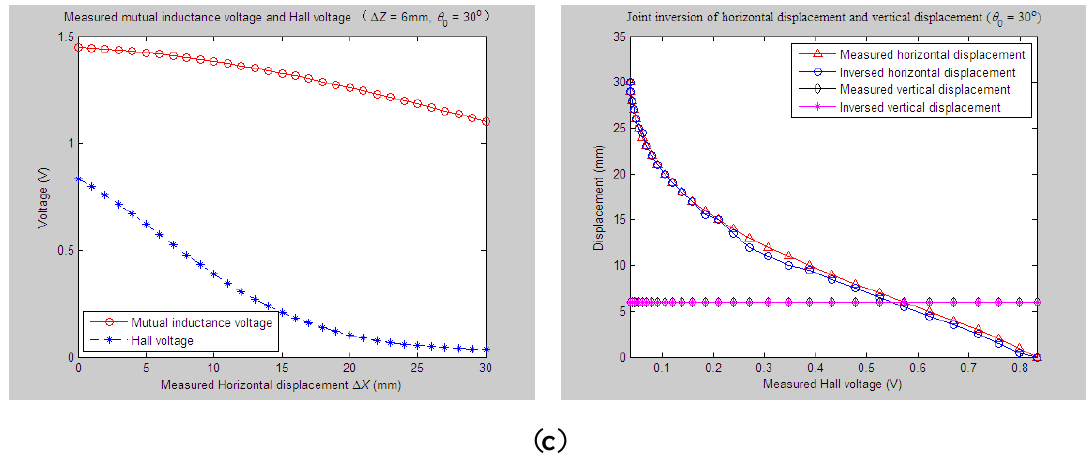
Figure 11. Inversed horizontal and vertical displacements vs. variations of Δ X and θ 0 (Δ Z = 6 mm). ( a ) θ 0 = 0°; ( b ) θ 0 = 20°; ( c ) θ 0 = 30°.